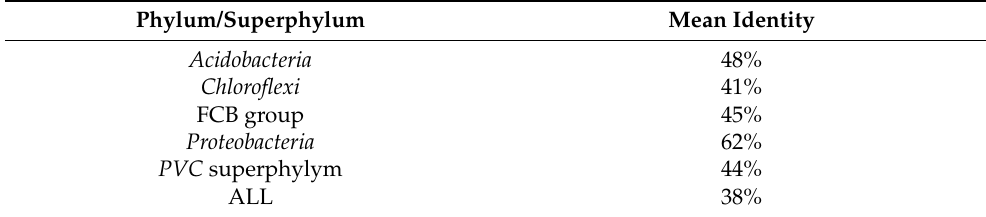
Table 3. Mean identity among azurin sequences. Identity referred to sequences for each of the analyzed phylum/supergroup and among all the sequences. Phylum/Superphylum Mean